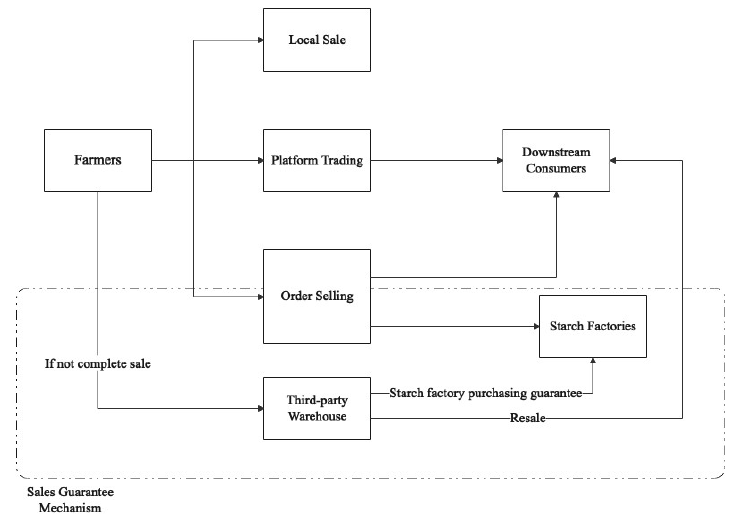
Figure 9. Sales model of the Tudouec platform from the perspective of farmers.